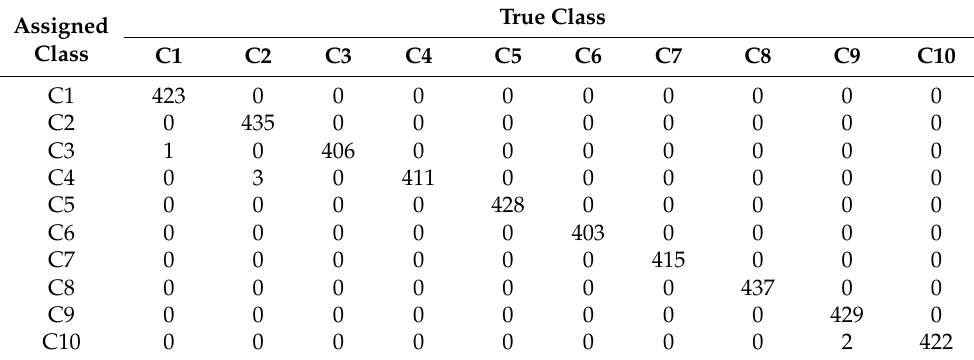
Table 3. Confusion matrix of the classification